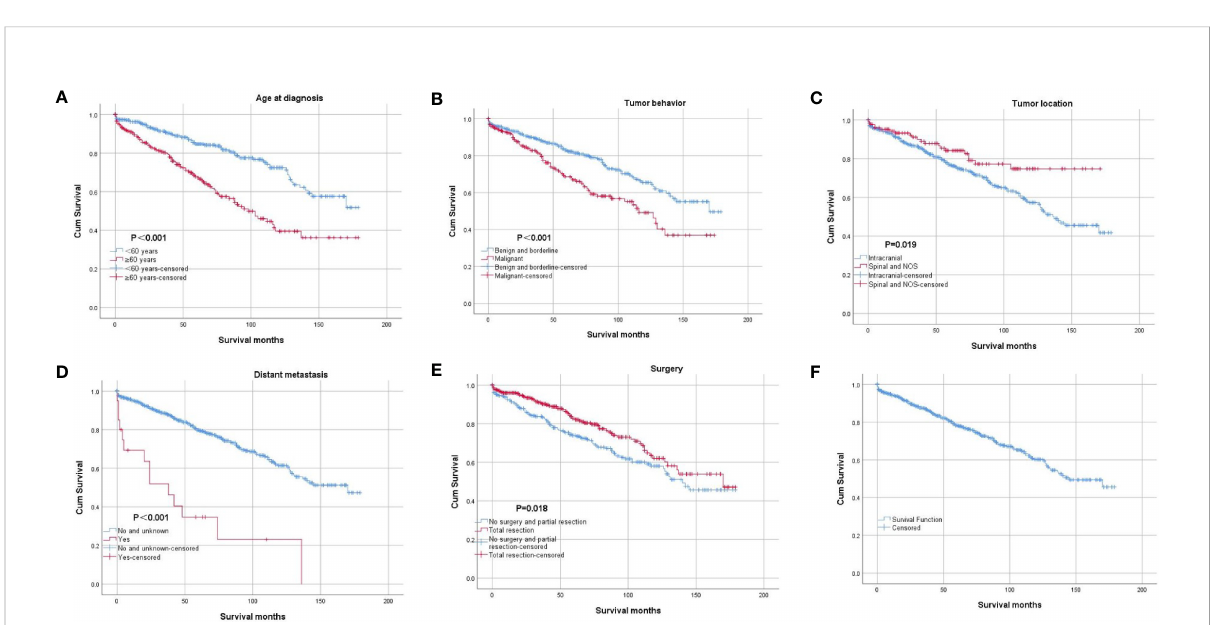
FIGURE 3 Kaplan – Meier curve of overall survival. The patients were strati fi ed by age at diagnosis (A) , tumor behavior (B) , tumor location (C) , distant metastasis (D) , and surgery (E) . Picture (F) showed the Kaplan – Meier curve of the whole